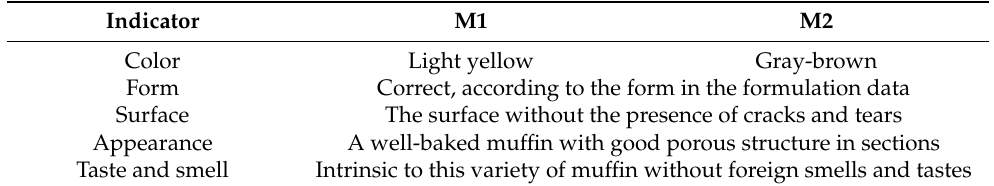
Table 2. Sensory characteristics of